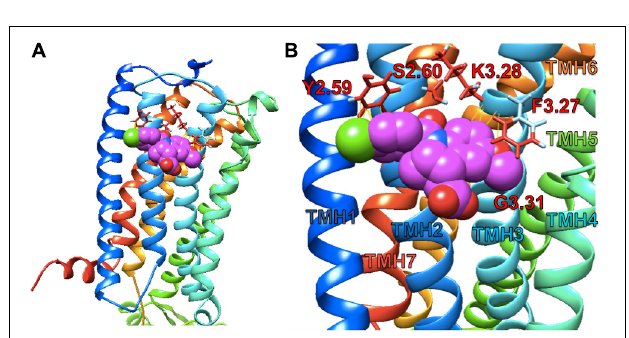
FIGURE 7 | Indomethacin docking to CB1R 5XRA (agonist-bound). (A) The perspective is from the lipid bilayer. Helices are blue (I), light blue (II), turquoise (III), seafoam (IV), green (V), gold (VI), and orange (VII). Indomethacin is shown in magenta. (B) Image as in (A) at a closer perspective. Interacting amino acid residues are named according to the Ballesteros and Weinstein (1995) system. Transmembrane helices (TMH) are labelled by number.